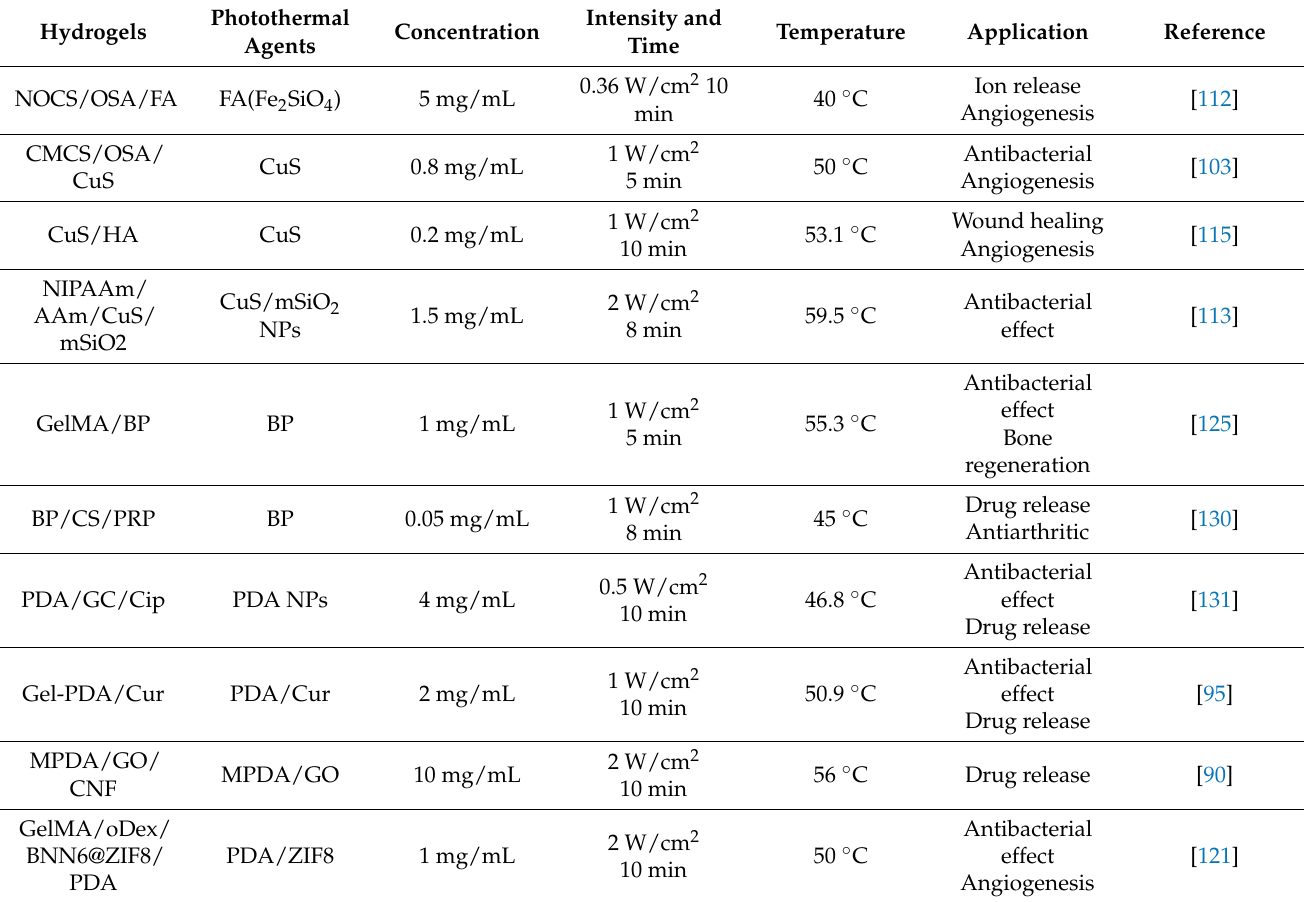
Table 1. Hydrogels with PTT for wound healing and bone